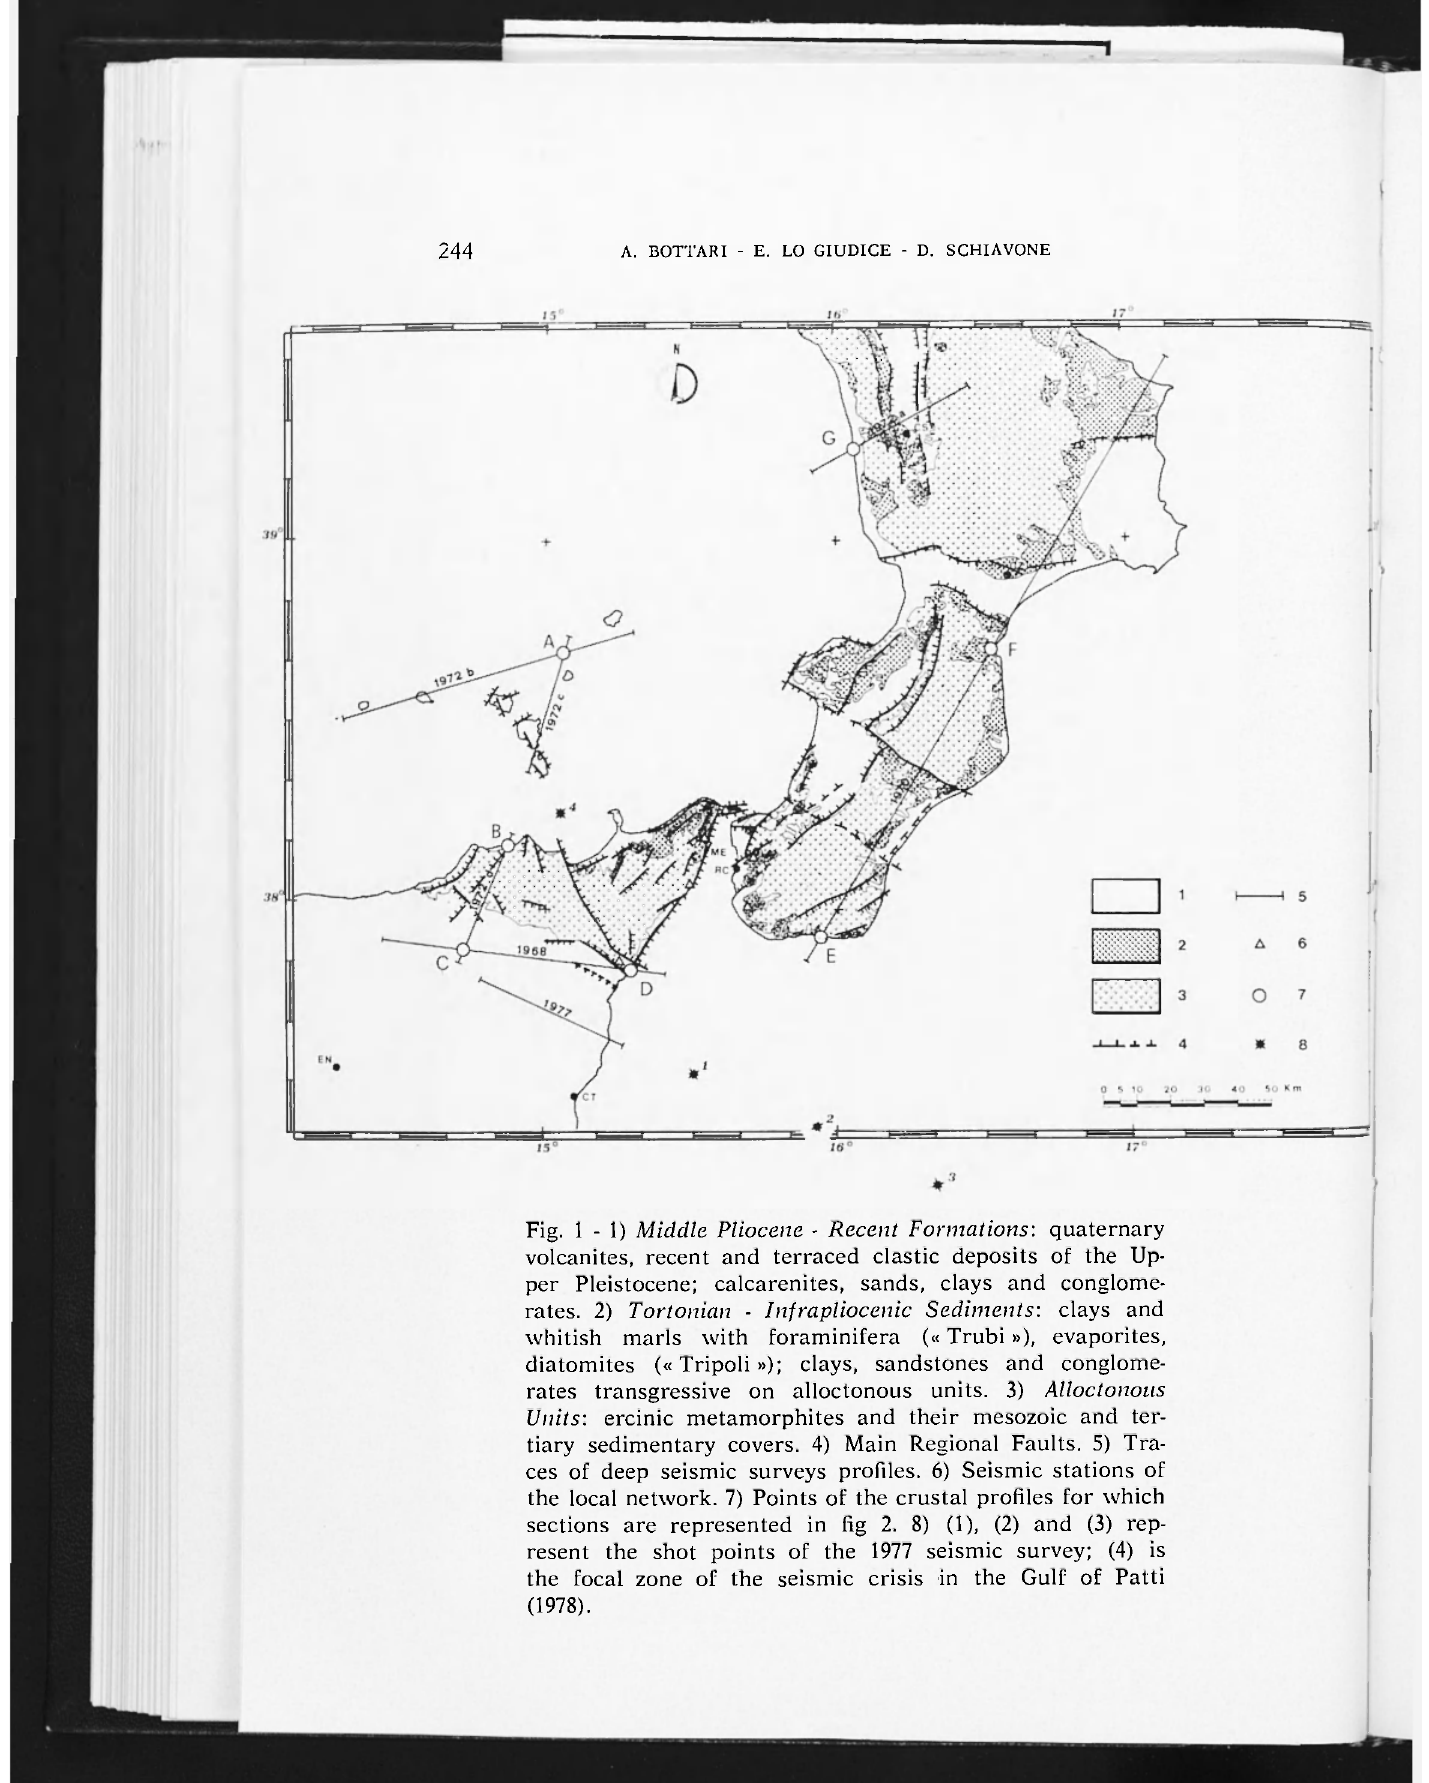
Fig. 1 - 1) Middle Pliocene - Recent Formations: quaternary volcanites, recent and terraced clastic deposits of the Up- per Pleistocene; calcarenites, sands, clays and conglome- rates. 2) Tortonian - Infrapliocenic Sediments: clays and whitish marls with foraminifera («Trubi »), evaporites, diatomites («Tripoli»); clays, sandstones and conglome- rates transgressive on alloctonous units. 3) Alloctonous Units: ercinic metamorphites and their mesozoic and ter- tiary sedimentary covers. 4) Main Regional Faults. 5) Tra- ces of deep seismic surveys profiles. 6) Seismic stations of the local network. 7) Points of the crustal profiles for which sections are represented in fig 2. 8) (1), (2) and (3) rep- resent the shot points of the 1977 seismic survey; (4) is the focal zone of the seismic crisis in the Gulf of Patti